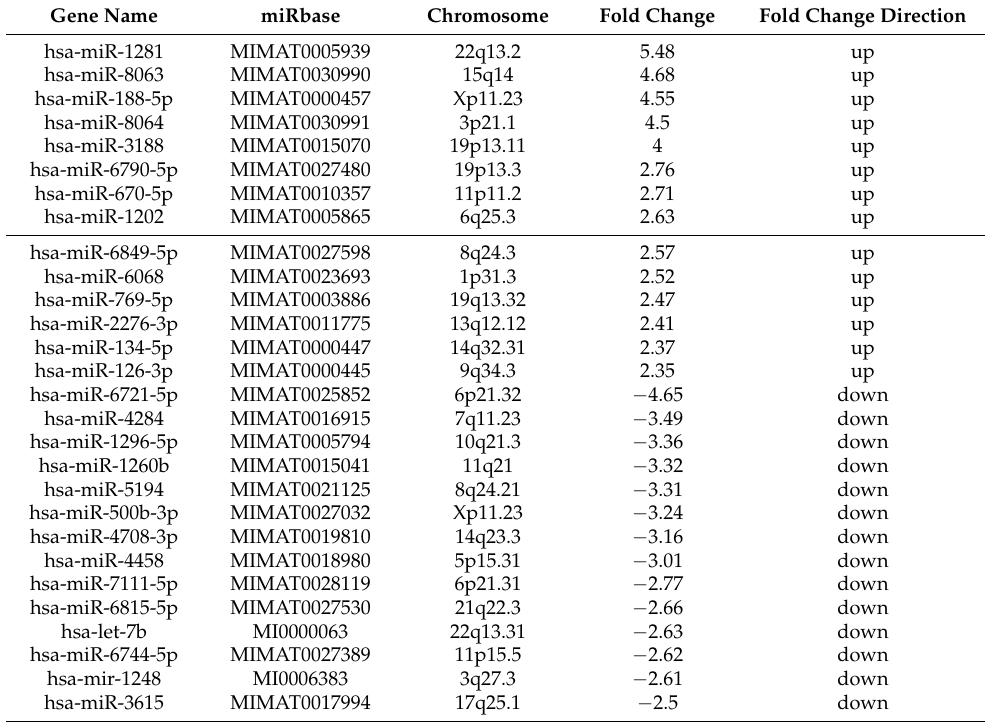
Table 1. Differentially expressed microRNA in HOXC6-induced FaDu